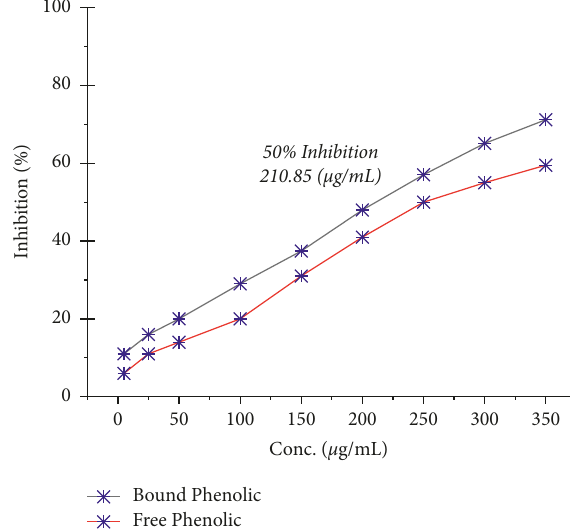
Figure 7: ACE (angiotensin-I converting enzyme) median in- hibitory potential of Veronica biloba